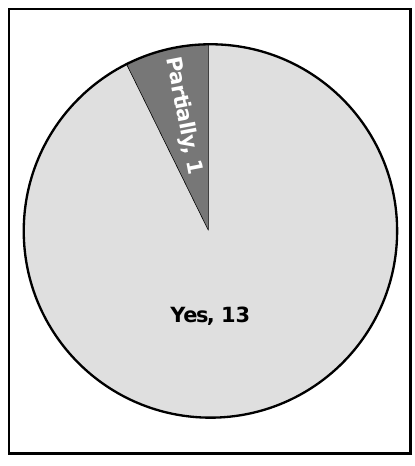
Figure 6: Participants’ percep- tions on whether or not their needs had been met (n=14). Poor